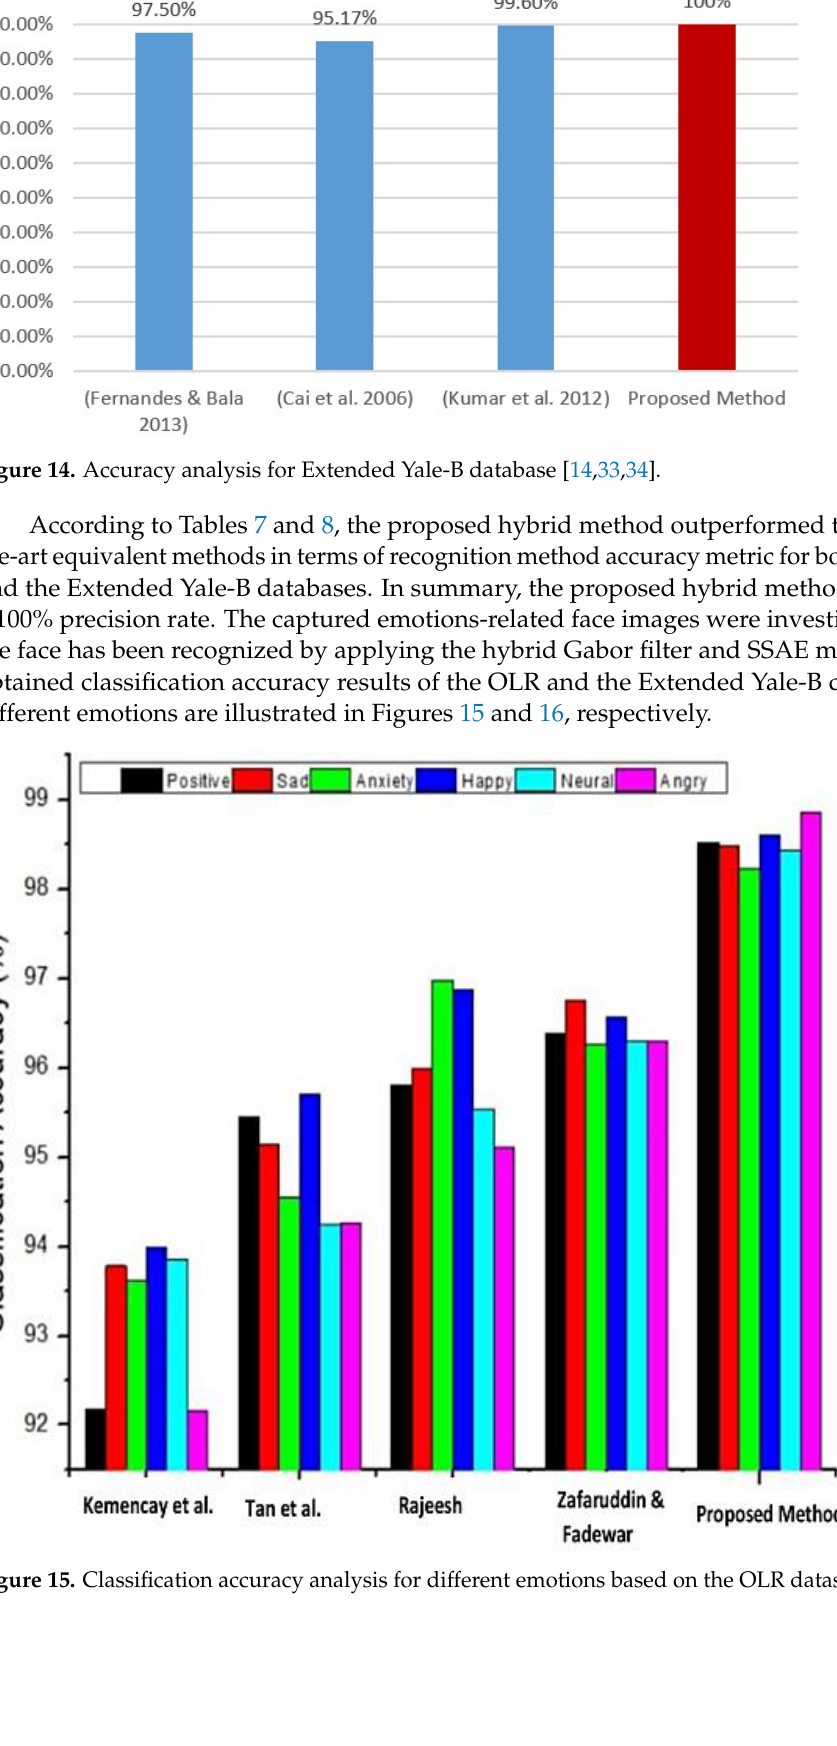
Figure 13. Accuracy analysis for OLR dataset [7,30 – 32].